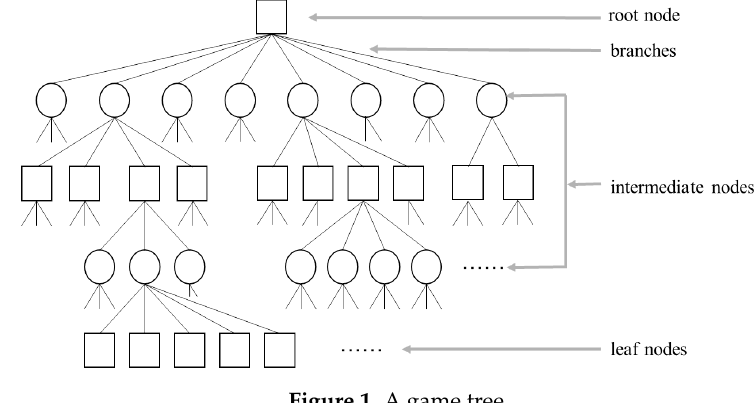
Figure 1. A game